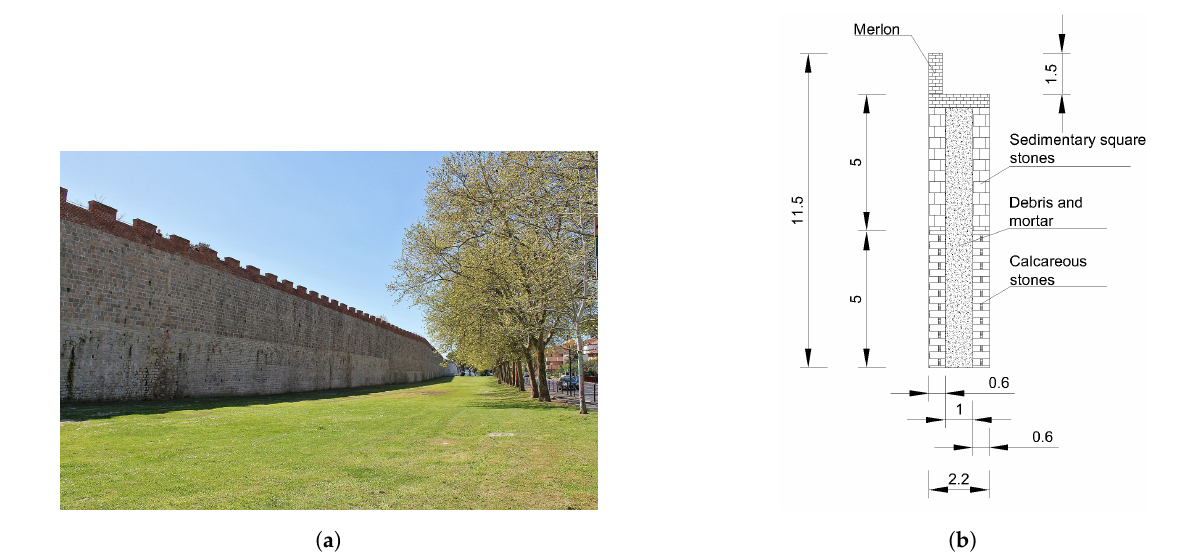
Figure 1. A photo of the Pisa fortification, reprinted with permission from ref. [27]. Licensed under the Creative Commons Attribution-Share Alike 4.0 International license. ( a ) and a reconstruction of the wall cross-section ( b )—measured in